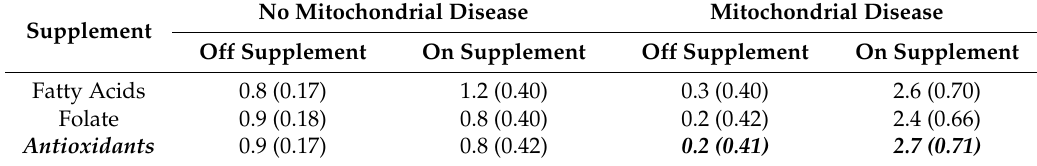
Table 4. Means (Standard Error) of Normalized Citrate Synthase activity on and off supplements by Mitochondrial Disease group. Supplements that are confirmed to be significant in the stepwise regression are bolded and